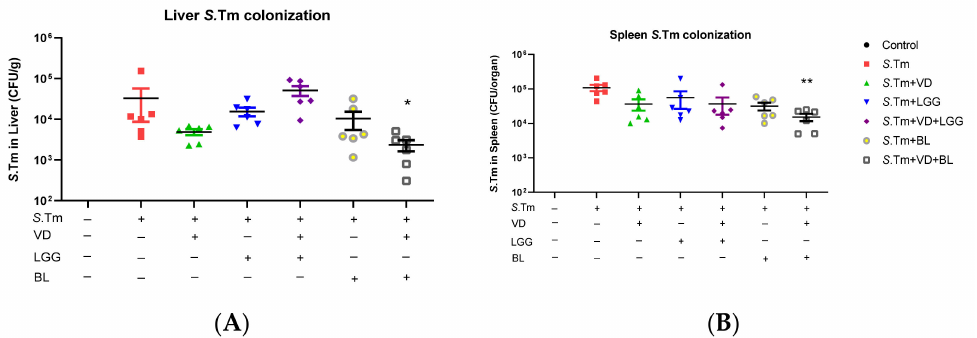
Figure 3. Combination of probiotics and active 1,25D3 attenuate systemic translocation of Salmonella . We infected 6–8 week-old female C57BL/6 mice with streptomycin, and incubated them with 10 8 CPU of S. typhimurium (SL1344 strain) for 48 h, along with vehicle, 1,25D3 or probiotics, Lactobacillus rhamnosus GG (LGG) or Bifidobacterium longum (BL) , daily as shown above. Numbers of bacteria translocated to liver or spleen were measured from liver ( A ) or spleen ( B ) homogenates of infected and/or treated mice. The data shown are represented as the means ± the SEM of the bacterial load in the liver and spleen ( n = 6). * p < 0.05, ** p <